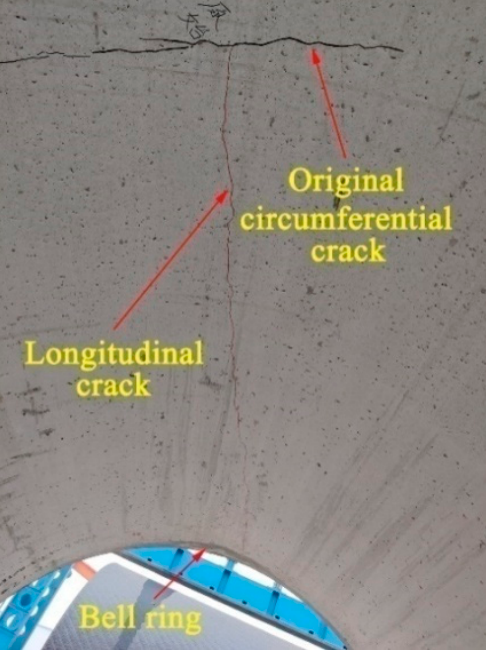
Figure 8. Longitudinal crack appeared on the internal surface of the test PCCP.